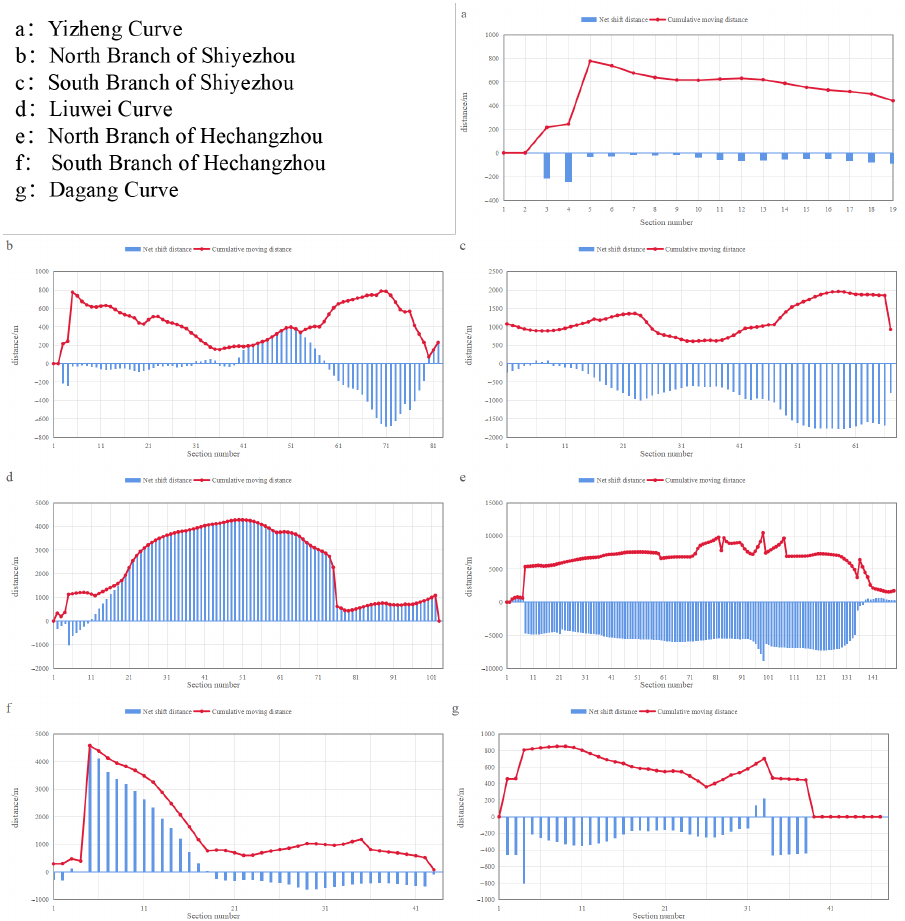
Figure 4. Changes of NSD and CMD of the channel centerline in Zhenjiang-Yangzhou reach. ( a ) Yizheng Curve; ( b ) North Branch of Shiyezhou; ( c ) South Branch of Shiyezhou; ( d ) Liuwei Curve; ( e ) North Branch of Hechangzhou; ( f ) South Branch of Hechangzhou; ( g ) Dagang Curve